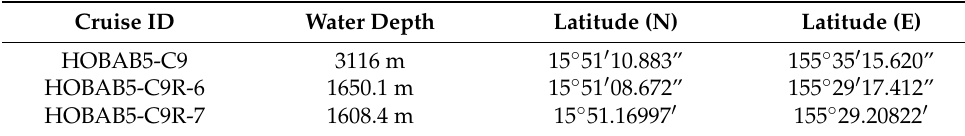
Table 1. Location of samples from Caiwei Guyot.